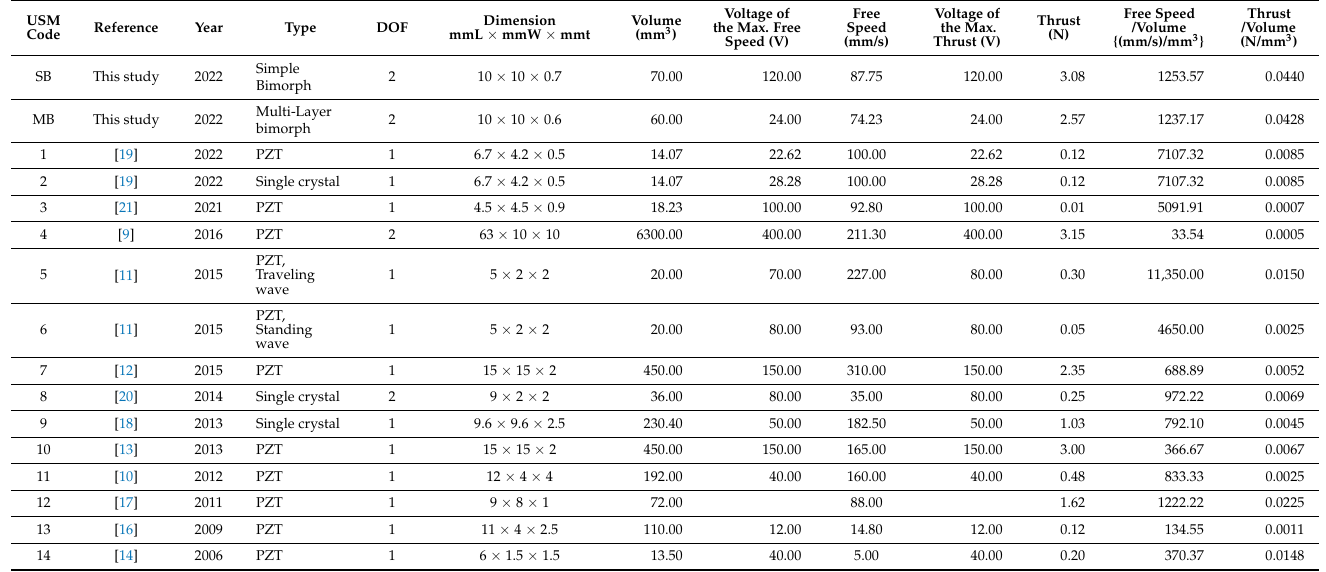
Table 3. Comparisons of the